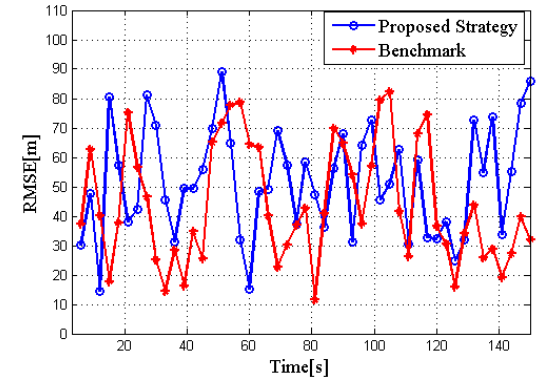
Figure 11. RMSE in two algorithms for target tracking in RCS case 2.